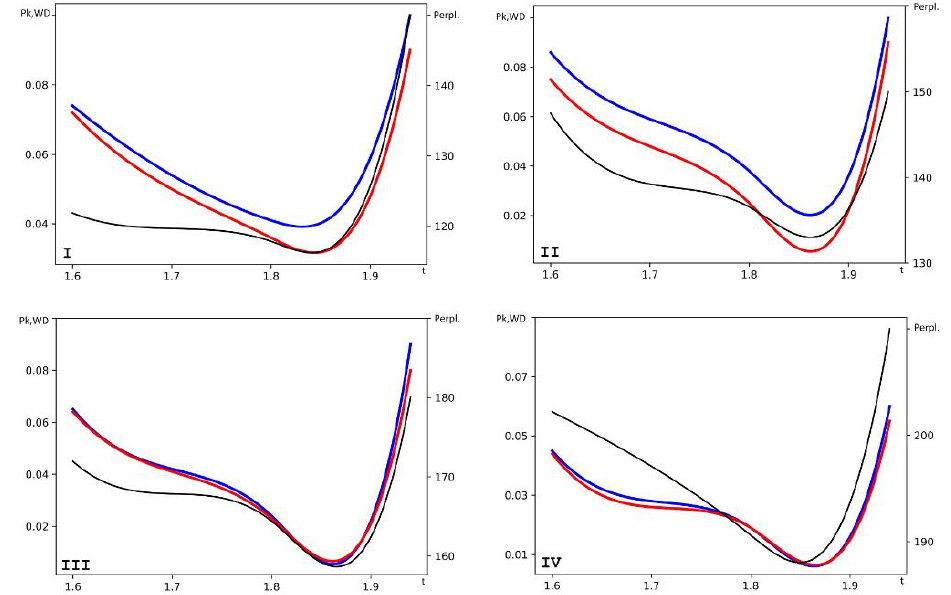
Figure 8. As segment boundary is determined by the semantic similarity threshold t corresponding to the minimum of text perplexity (black line), segmentation errors Pk (blue line) and WD (red line) are also minimized. Calculations were performed on the Choi data subsets with segment sizes of ( I ) 3–11, ( II ) 3–5, ( III ) 6–8, and ( IV ) 9–11 sentences. (Note that unlike the perplexity score, Pk and WD , to be computed, both require gold-standard segmentation of documents.) Appl. Sci. 2022 , 12 , x FOR PEER REVIEW